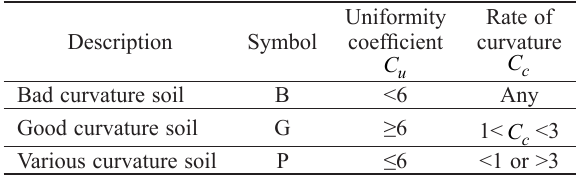
Table 1. Classification of soils by uniformity coefficient and rate of curvature (LST 1331:2015) Description Symbol